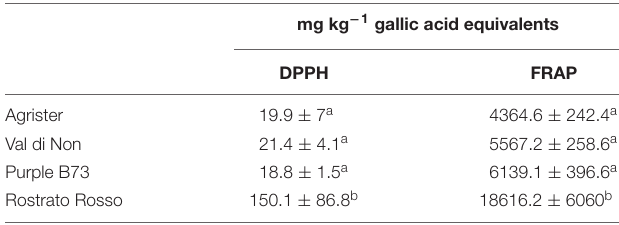
TABLE 5 | In vitro antioxidant capacity values in the selected maize genotypes, as obtained through DPPH radical scavenging and FRAP reducing power